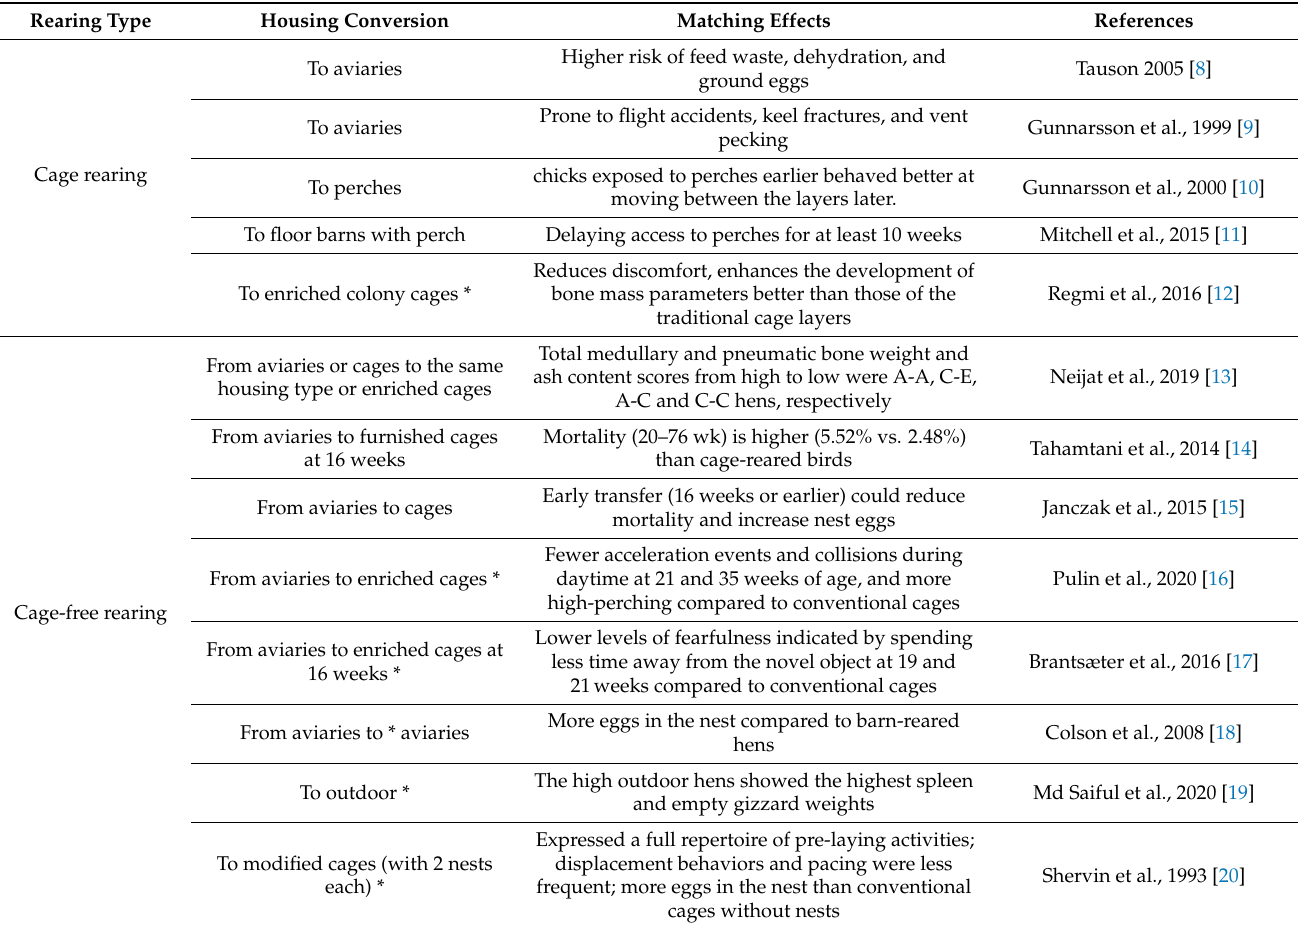
Table 1. The matching effects of different housing types on transfers from rearing to